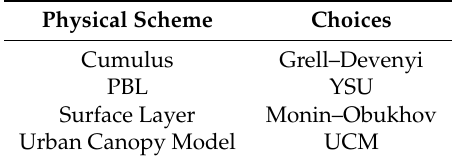
Table 4. Selection of other physical parameterization schemes. (PBL: Planetary Boundary layer, YSU: Yonsei University).